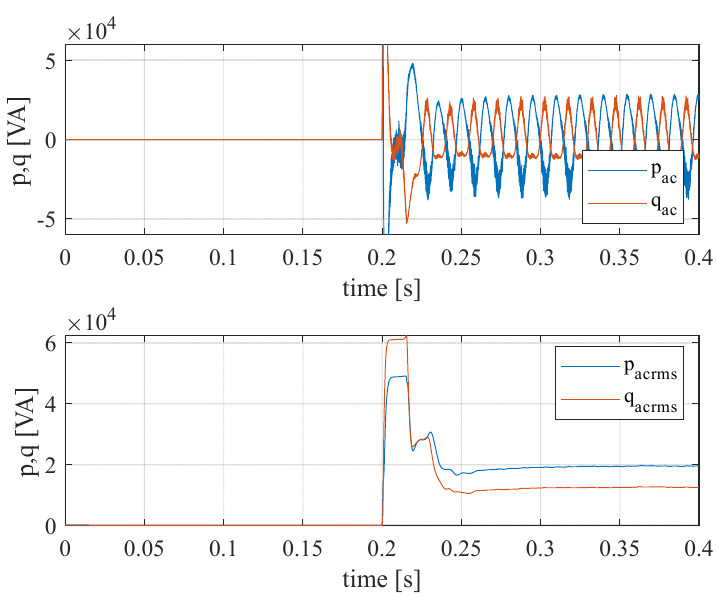
Figure 21. Active and reactive power when PMSM loaded ICE engine as the generator.